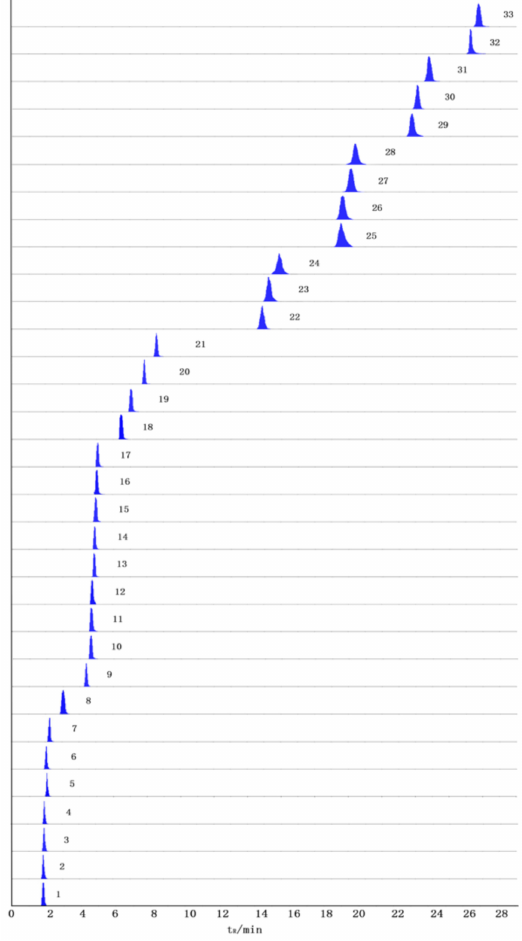
Figure 1. Representative extract ion chromatograms (XIC) of multi-reaction monitoring (MRM) chromatograms of 33 investigated constituents in the